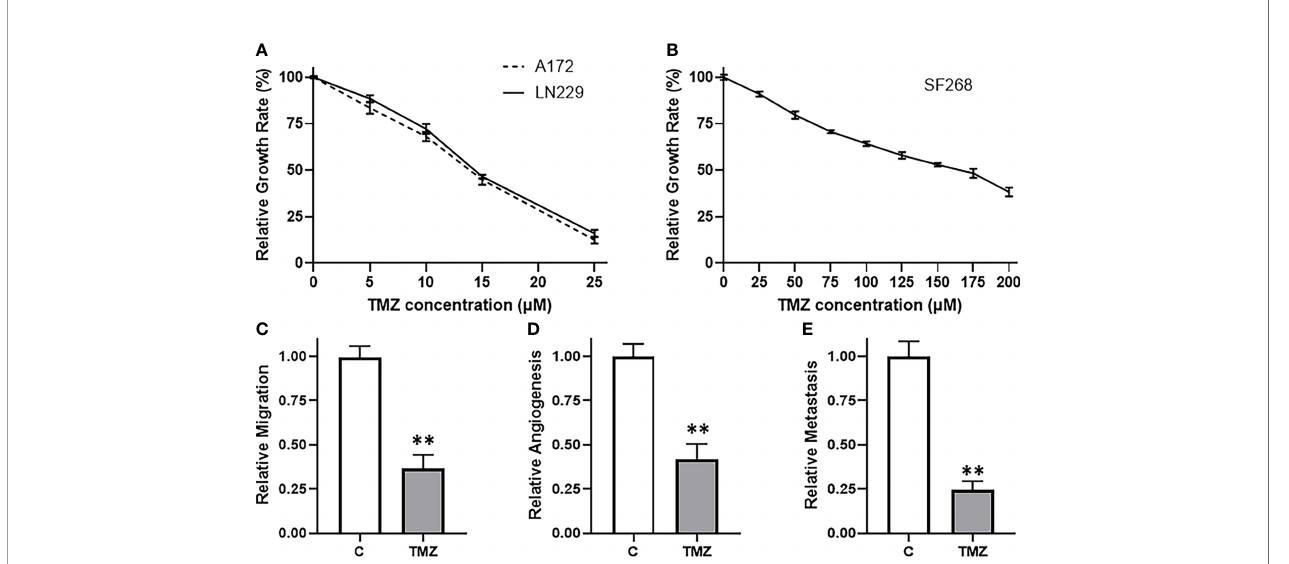
FIGURE 1 | SF268 are resistant to TMZ. MTT assays were performed to test the sensitivity of (A) A172 and LN229 and (B) SF268 glioma cells against TMZ after 3 day cycle. Vehicle treated control vs. 160 m M TMZ treated SF268 cells were subjected to assays for migration (C) , VEGF secretion (D) and MMP-9 secretion (E) . VEGF and MMP-9 were detected by ELISA as surrogates for angiogenesis and metastasis, respectively. The values of controls were regarded as ‘ 1 ’ and relative values of TMZ-treated SF268 cells are reported. C: control, TMZ: TMZ-treated SF268 cells **p < 0.01.